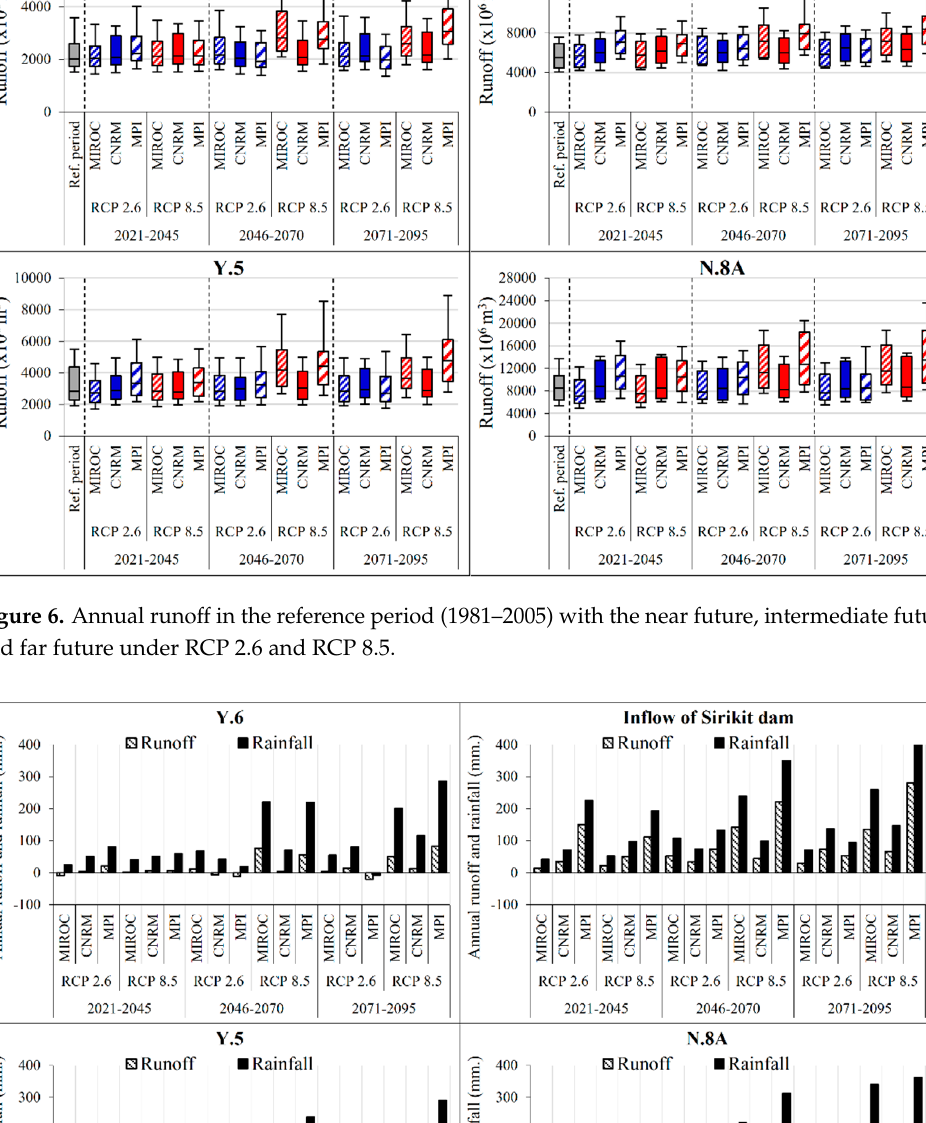
Figure 8. Changes in average rainfall during wet and dry seasons in the reference period (1981– 2005) with the near future, intermediate future, and far future under scenarios RCP 2.6 and RCP 8.5.